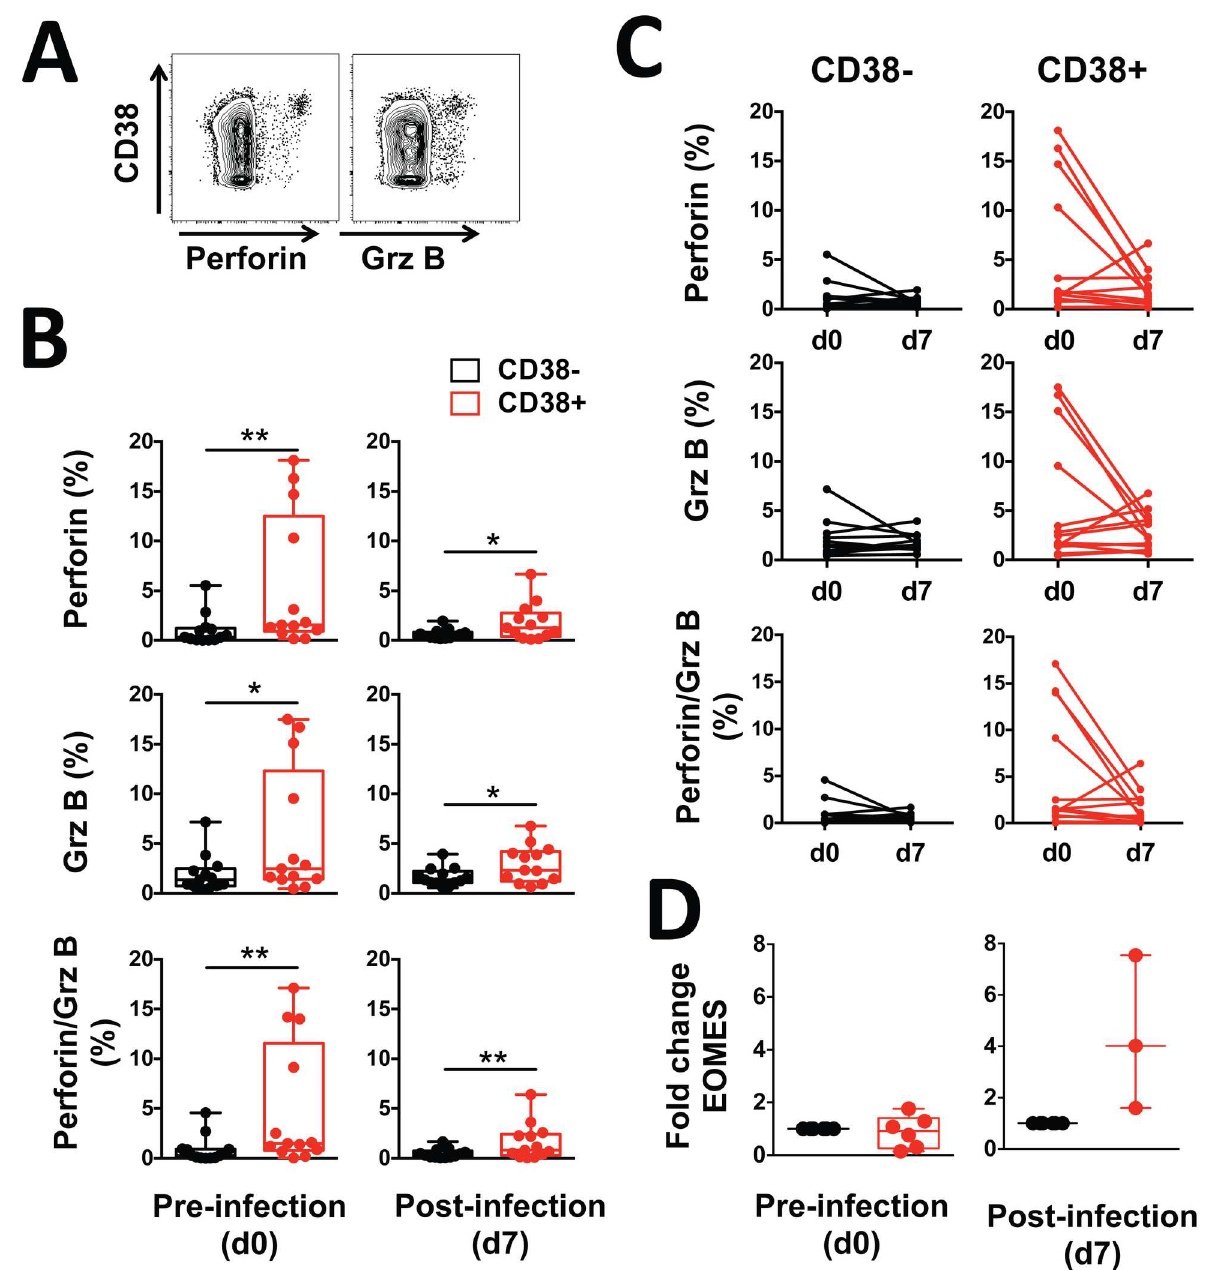
Fig 3. CD38 + CD4 + T cells have a phenotypeassociated withcytotoxic potential. (A) Representative stainingin one volunteer and (B-C)frequenciesof CD38 - (black) or CD38 + (red)CD4 + T cells expressing perforin + , granzyme B + (GrzB)or perforin + /granzymeB + determined by flow cytometryin volunteers priorto and seven days post infection. (D) Eomes gene expression measuredby RT-qPCR in CD38 - (black) or CD38 + (red)CD4 + T cells isolatedfromvolunteers priorto and seven days post infection. Graphs show combined data from(A-C)13 volunteers fromtwo independent cohorts,(D) seven (pre)and three(post)volunteers fromone cohort. Statistical differences between CD38 - and CD38 + CD4 + T cells or between pre-and post-infection were determined using the non-parametric Wilcoxon test;box and whisker plots indicatemedian,interquartilerange and min-max; * , p < 0.05; ** , p < 0.01; *** , p < 0.001; **** , p < 0.0001.